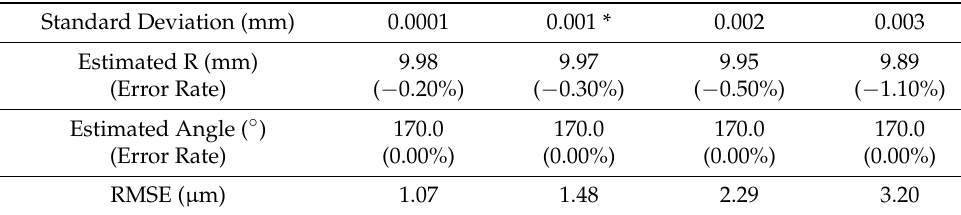
Table 3. Estimated radii and angles for different standard deviations of the Gaussian noise. Reference value is marked with an asterisk (*).